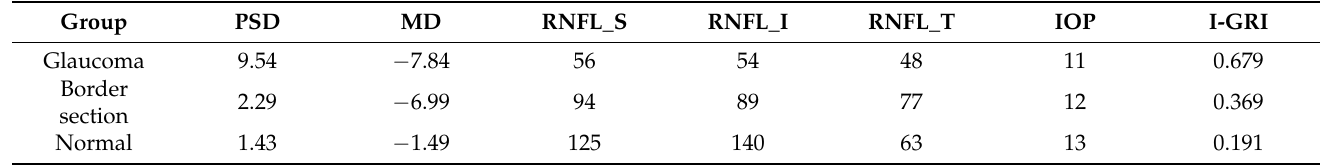
Table 10. Target examination data for the calculation of the